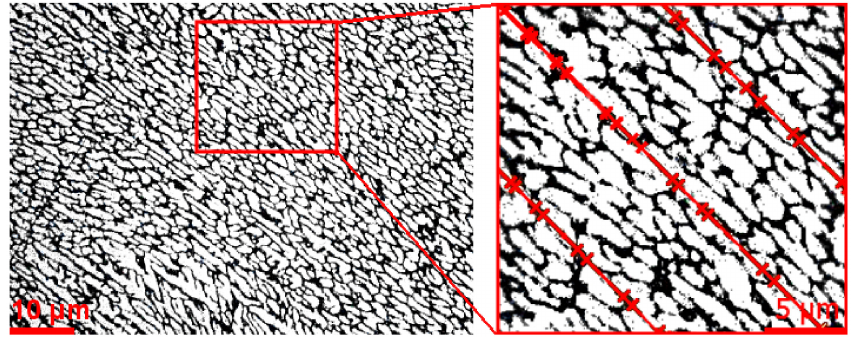
Figure 4. Linear intercept method used on binarized images under a magnification of 150 ×